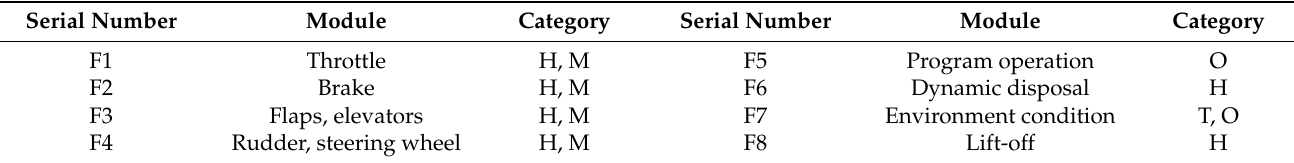
Table 1. Pilot function modules.